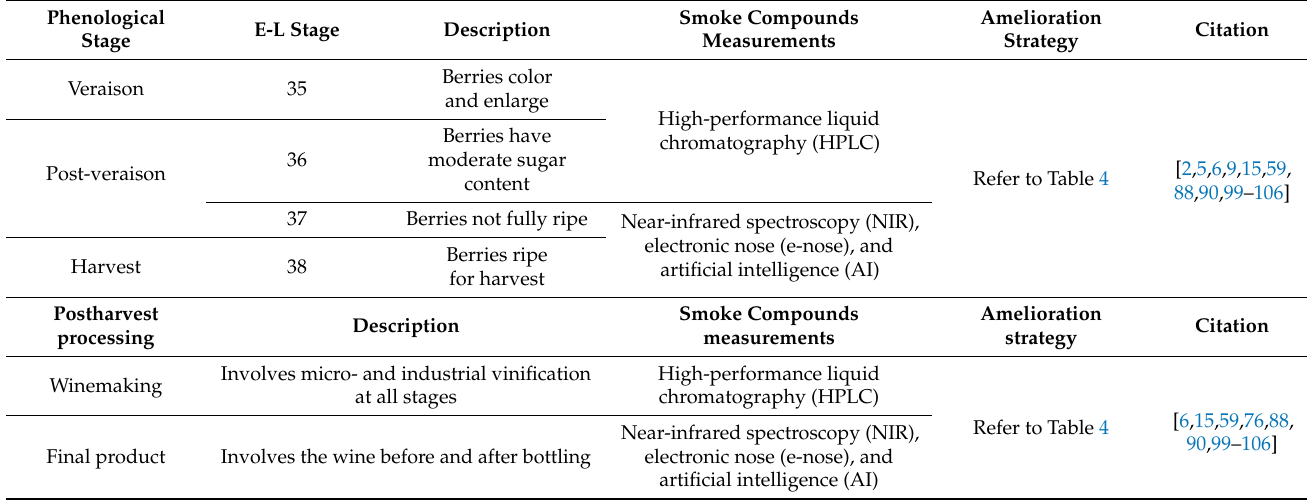
Table 5. Summary of the main grapevine phenological stages where there is a high risk of smoke taint and respective smoke compound measurement